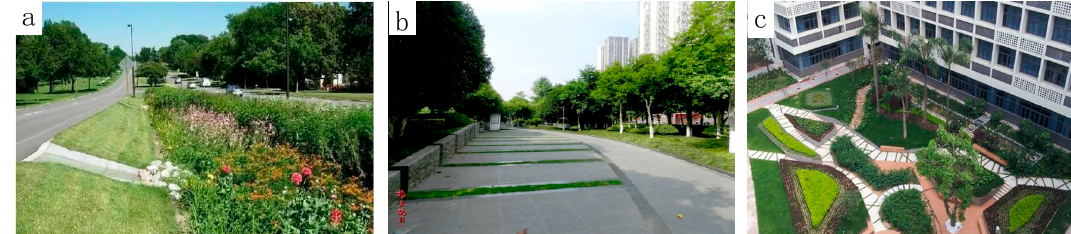
Figure 16. The instance of optimization results in low-impact development (LID): ( a ) concave herbaceous field; ( b ) sunken green space square; and ( c ) grid construction inside the campus.